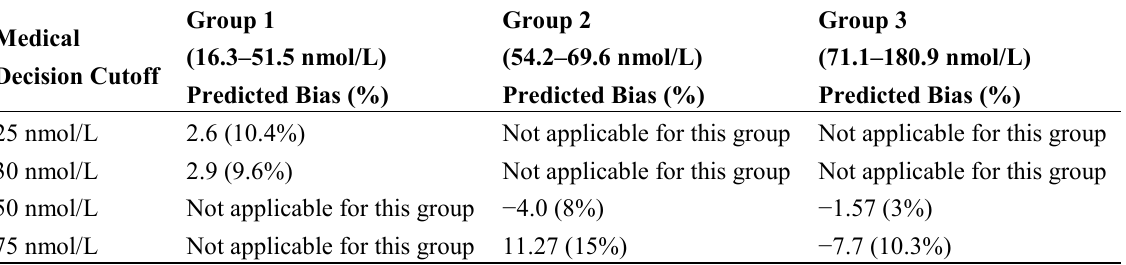
Table 3. Calculated predicted biases at four medical decision cutoffs for low, middle and high